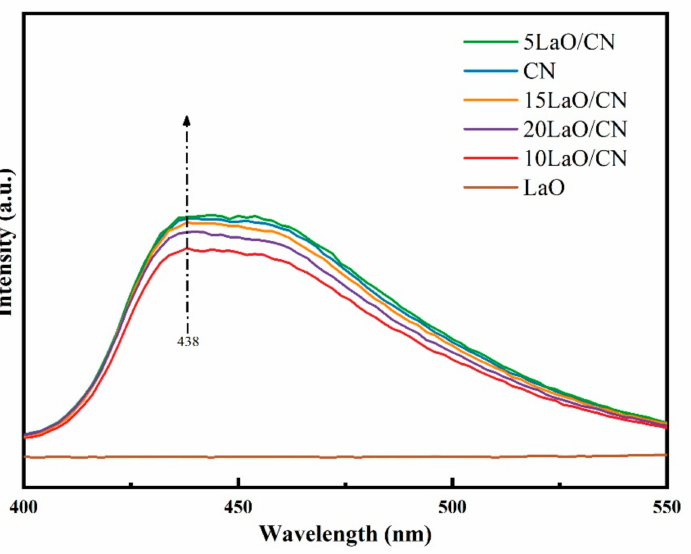
Figure 6. PL emission patterns of CN, 5LaO/CN, 10LaO/CN, 15LaO/CN, 20LaO/CN and LaO